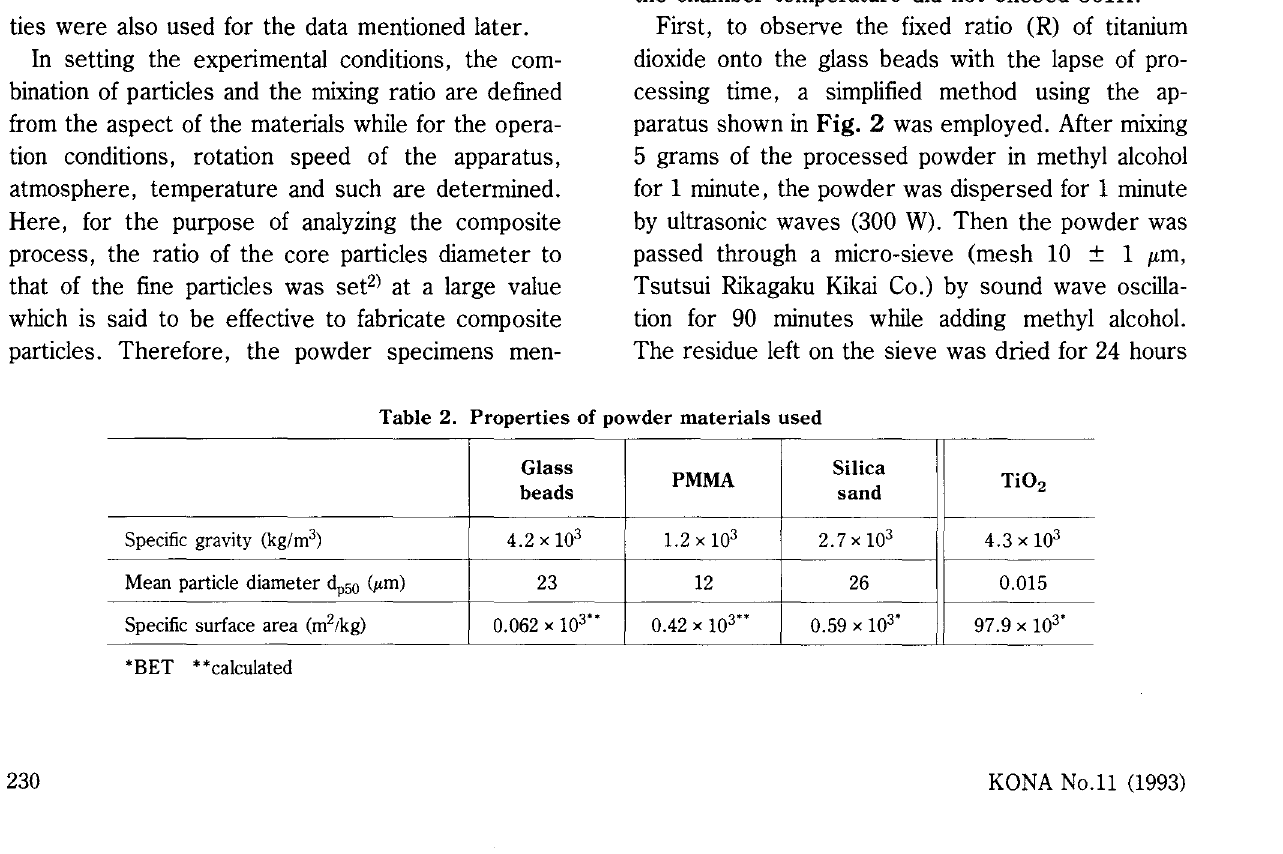
Fig. 1 Experimental apparatus for fabricating composite par ticles (MECHANOFUSION SYSTEM, Hosokawa Micron